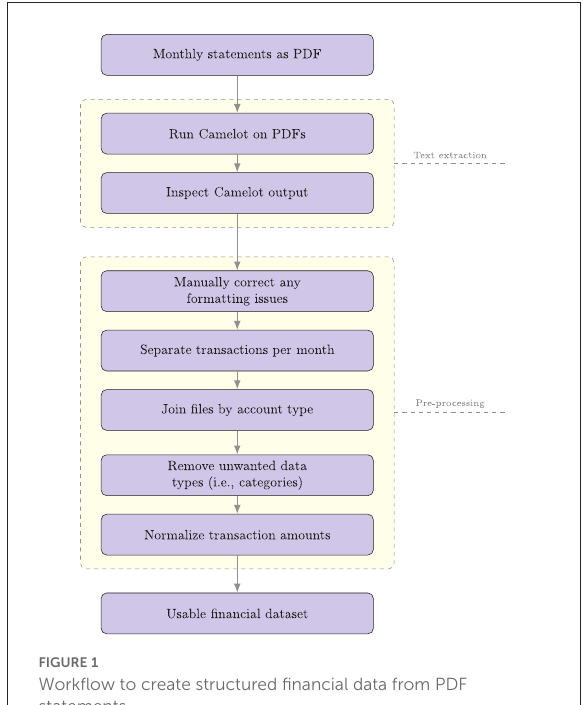
FIGURE1 Workflow to create structured financial data from PDF